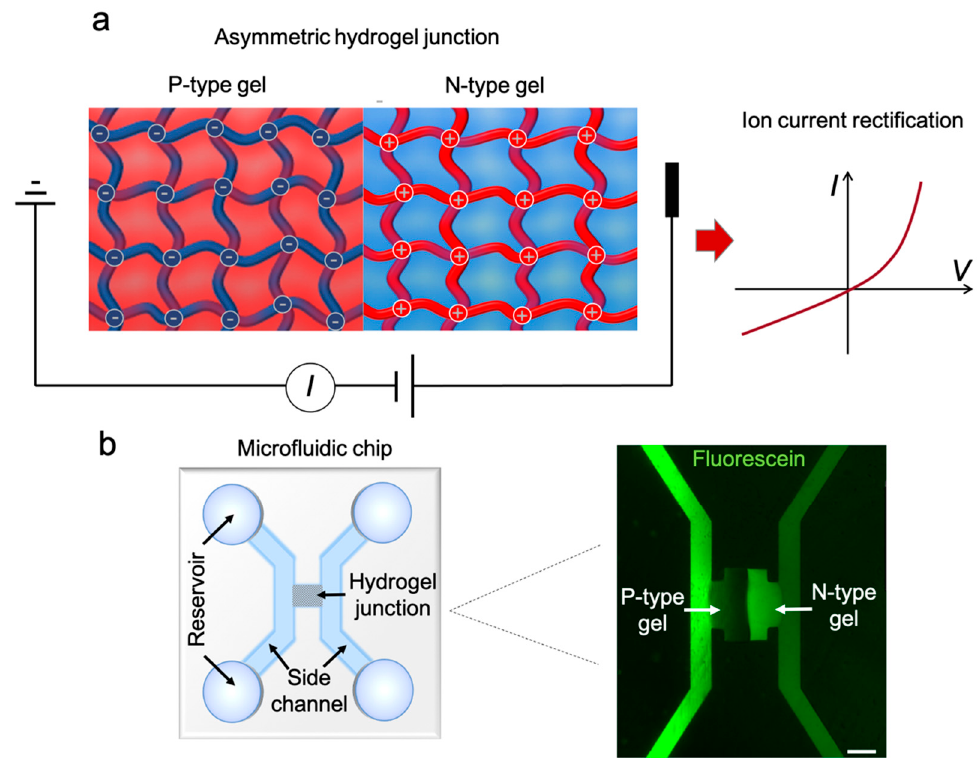
Figure 1. Illustration of a PHID device and its working principle: ( a ) Conceptual illustration of a polyelectrolyte heterojunction. The intertwined meshes represent hydrogel backbones with their color denoting charge polarities (red, positively charged and blue, negatively charged). The colored background denotes the counter ions in the nanopores (red, positively charged ions and blue, negatively charged ions). The asymmetry in distribution of charge carriers leads to asymmetric I-V characteristics; ( b ) the PHID device layout (left) and a fluorescent micrography showing hydrogel heterojunction of a representative device. Scale bar, 50 μ m.